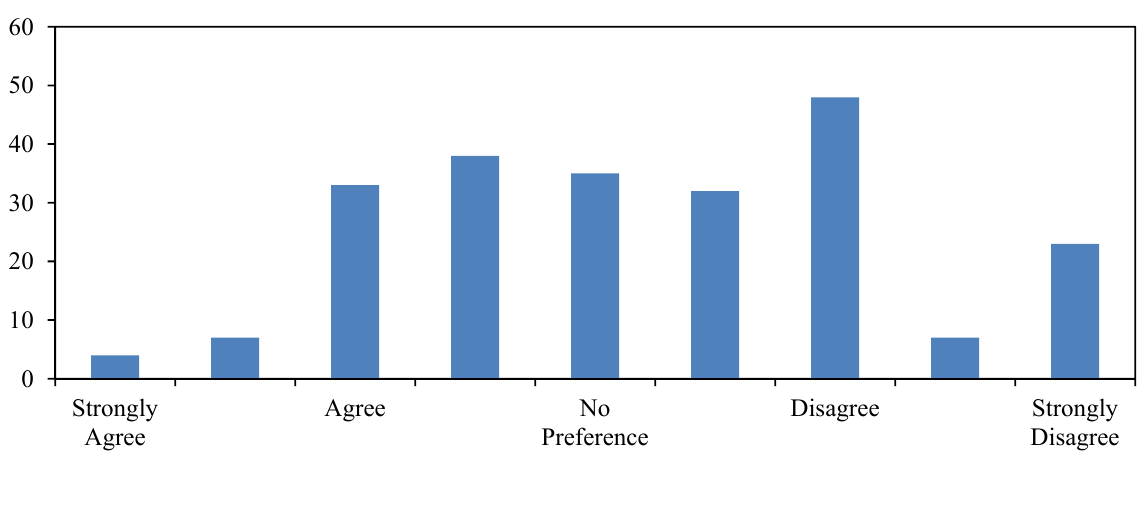
Figure 12. Graph of responses to the statement “I would trust a computer to determine what data is sent back to Earth versus being discarded”.